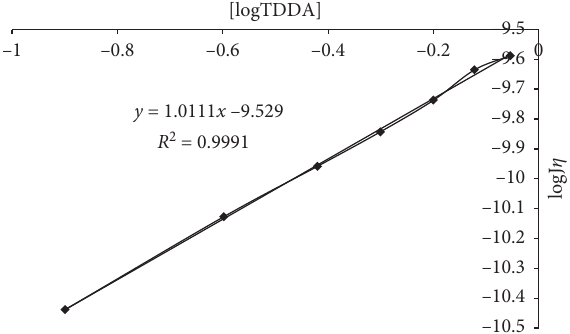
Figure 3: Plot of log [TDDA] versus log J η (the same operating conditions as given in Figure 2).